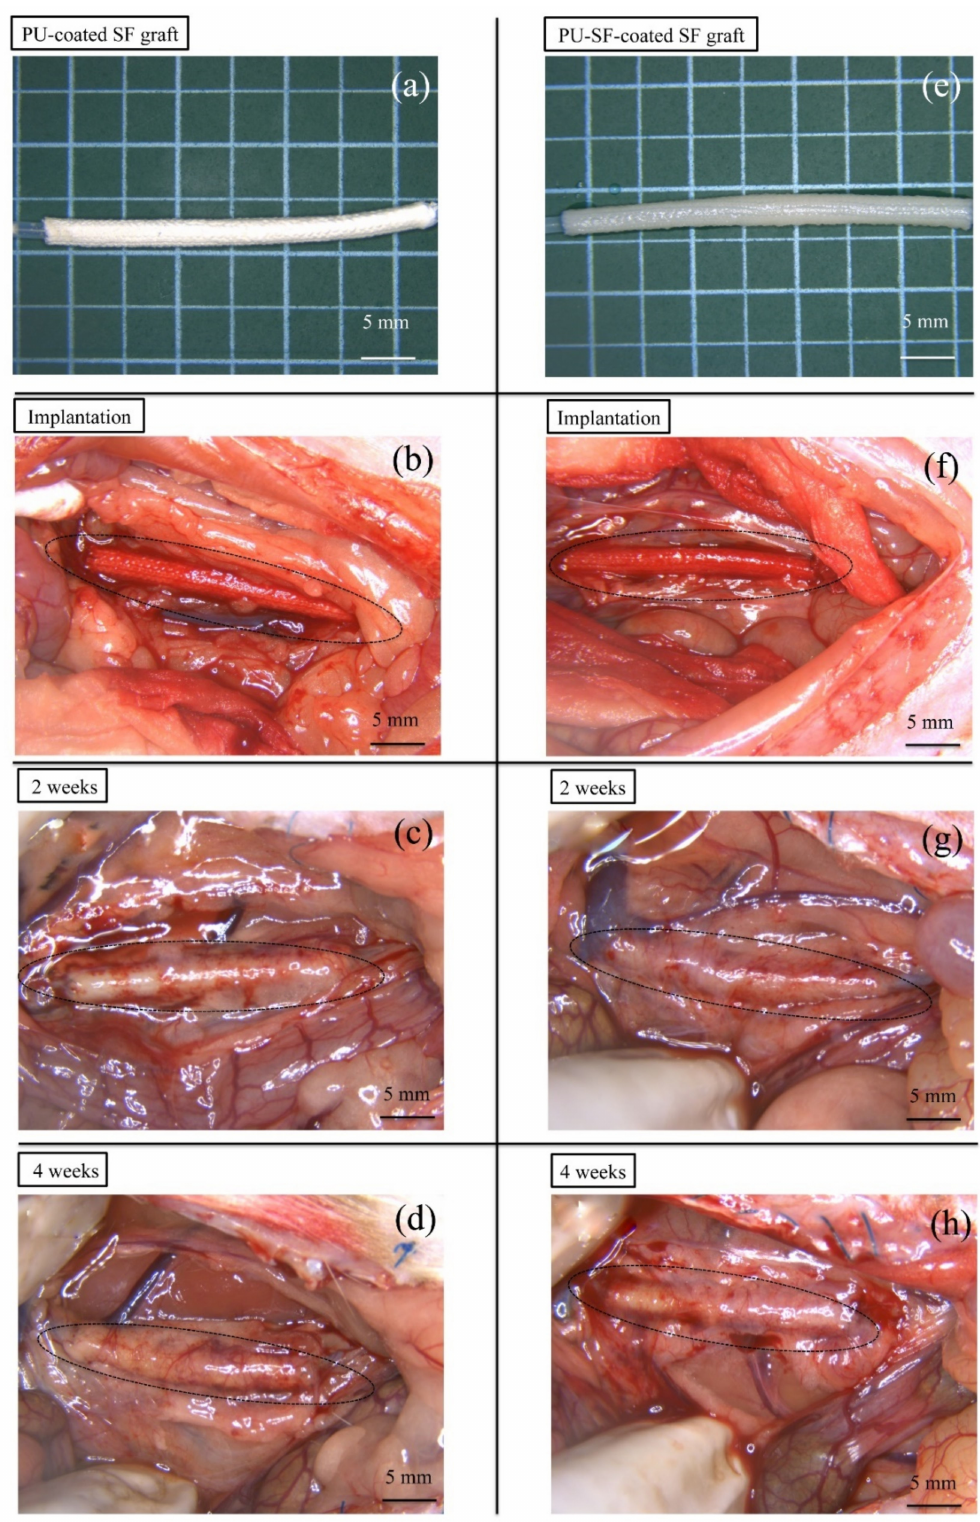
Figure 9. PU-coated ( a ) and PU-SF-coated SF grafts ( e ) before implantation. Photographs of the PU- ( b ) and PU-SF-coated grafts ( f ) immediately after releasing the vascular clamp after implantation. Hemostasis was achieved in all the grafts, and no deaths due to bleeding occurred. Photographs of the microscopic findings during extraction of the grafts: ( c ) the PU- and ( g ) PU-SF-coated grafts at 2 weeks after implantation, and ( d ) the PU- and ( h ) PU-SF-coated graft at 4 weeks after implantation. Bending, dehiscence, granuloma, hematoma, and aneurysm formation were not observed. Peeling of the surrounding tissue from these grafts was easy, and no fatal bleeding was